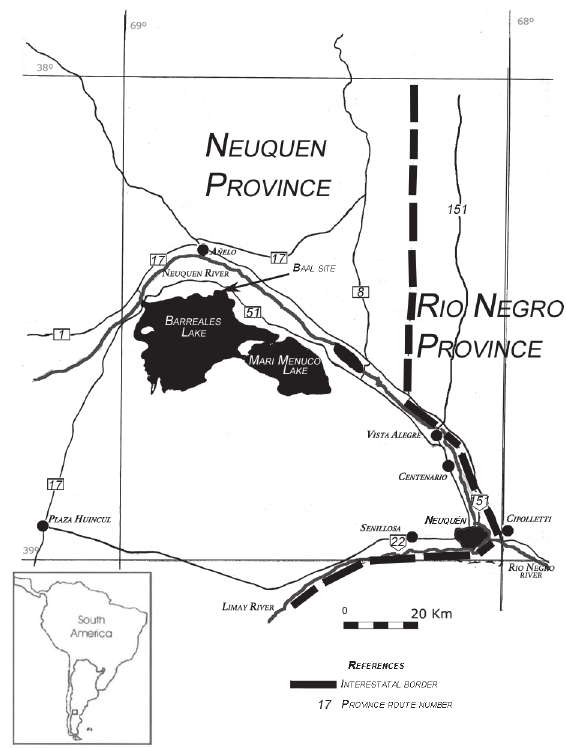
Figure 1 - Map of Neuquén Basin (Patagonia, Argentina) showing the locality where the holotype Baalsaurus mansillai gen. et sp. nov. was